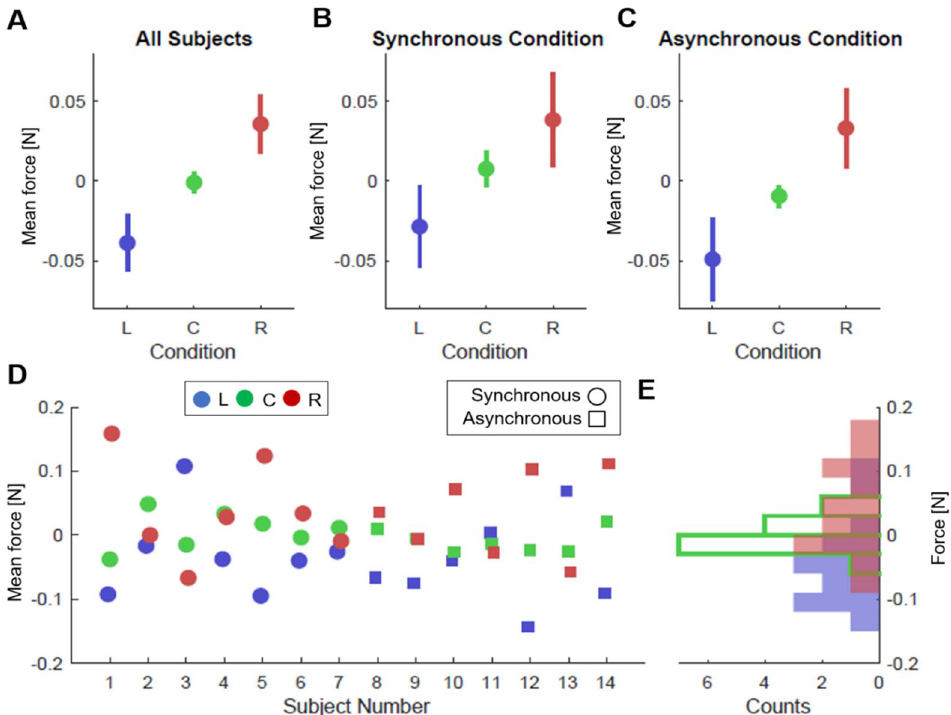
Figure 4. Mean forces applied during stimulation for the different virtual hand location conditions: Left (blue), Center (green), Right (red). The center condition corresponds to the location of the real hand. ( A ) Mean and standard deviation of the force applied by all subjects for the three different virtual hand locations. ( B ) Mean force in the synchronous condition, where tactile (vibrator) and visual stimulation (ball hitting the hand) events were concurrent (i.e. both occurring within less than 100 ms). ( C ) Mean force in the asynchronous condition, where the tactile event was generated randomly along the trajectory of the ball. ( D ) Mean force registered during stimulation for each participant. Three continuous points in the x-axis (L-blue, C-green, R-red) describes one subject. ( E ) Mean force histogram for the three virtual hand location conditions (all